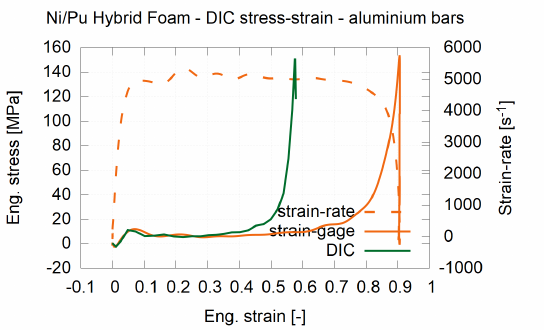
Figure 4. Representative median value of the correla- tion coefficient plotted against strain for three selected experiments (test 270 - short sample at low strain rate, test 285 - short sample at high strain rate, test 317 - long sample at high strain rate)